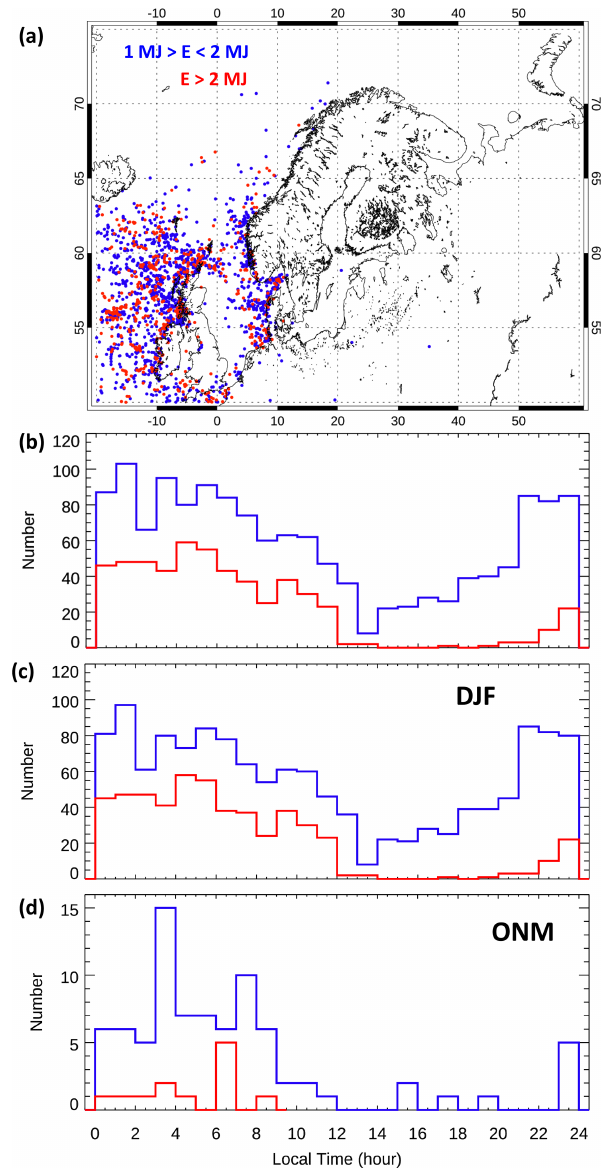
Figure 4. (a) Spatial distribution of superbolts (strokes with ener- gies of 1–2MJ and above 2MJ are respectively represented by blue and red). (b) Temporal distribution of superbolts as a function of the local time. The same as in (b) , but for DJF (c) and ONM (d) .